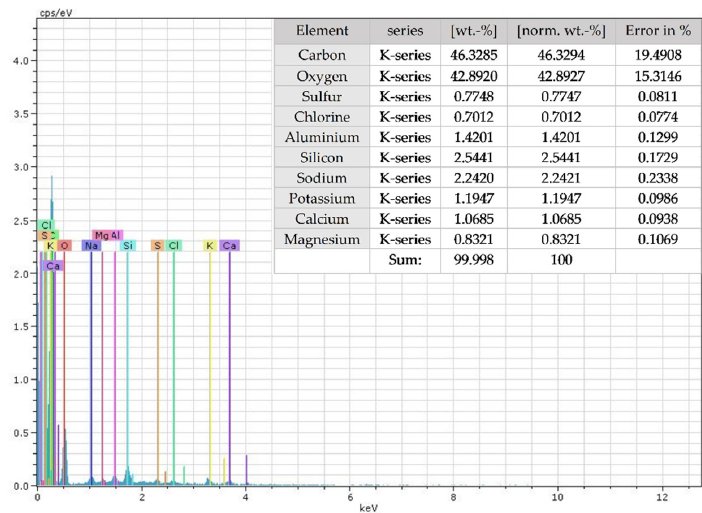
Figure 8. EDX spectrum for the varnish sample, zone 3.